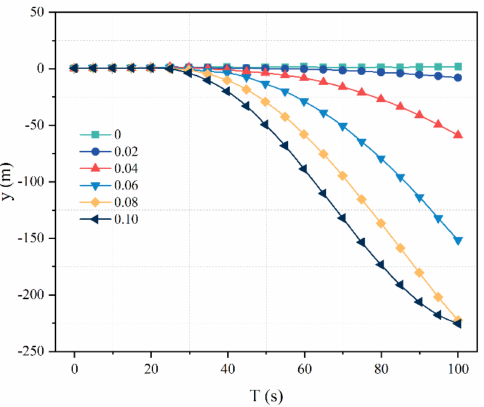
Figure 5. Lateral displacement under different Munk moment coefficients.